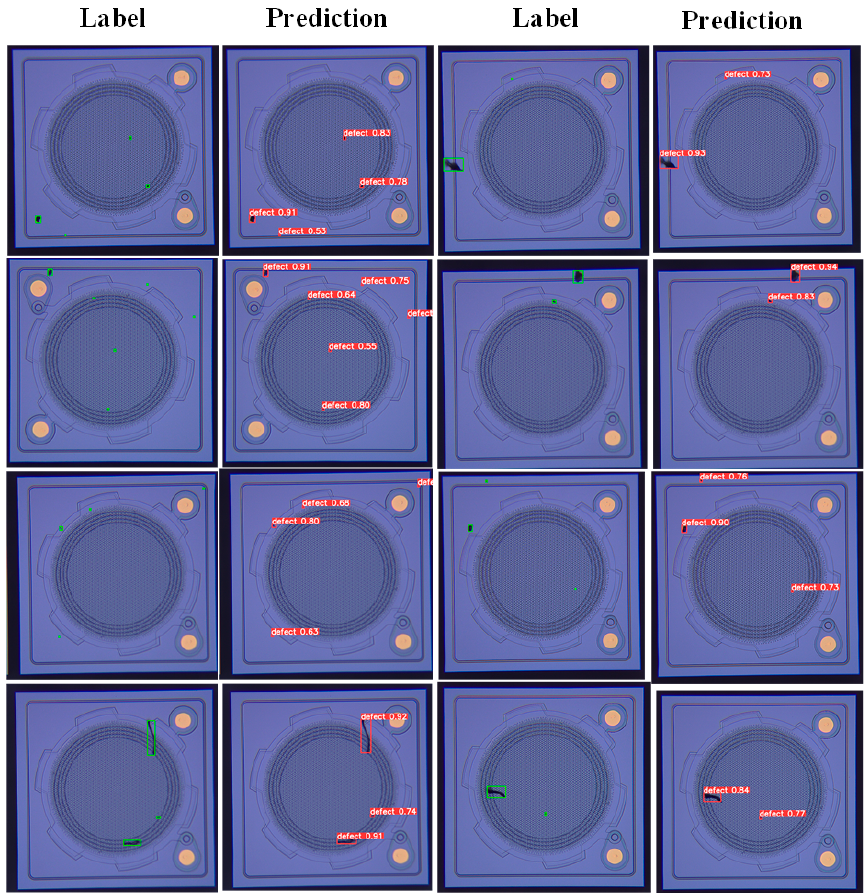
Figure 13. The detection results of the optimal model.